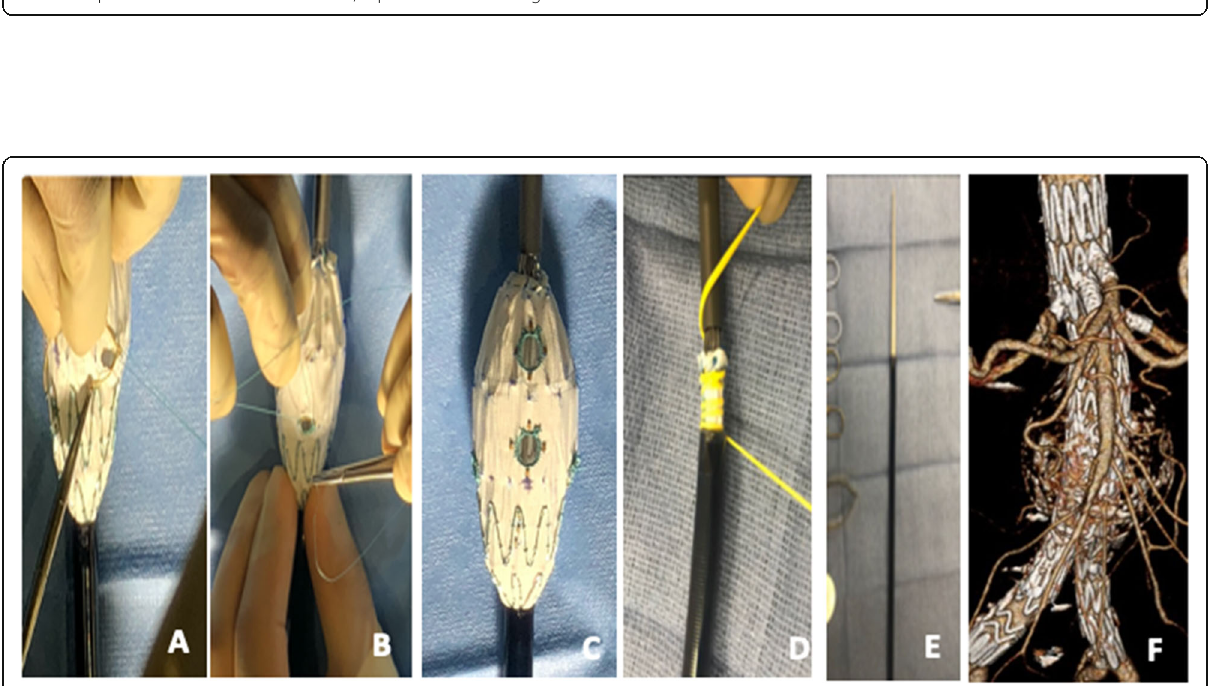
Fig. 4 A-H. Steps of modification of the Zenith Alpha thoracic stent graft. The device is deployed on a sterile back Table ( A ). The bottom stent is cut with an ophthalmologic cautery to ensure adequate length to the flow divider of the failed stent graft. Fenestrations are created and reinforced as described in Fig. 1B ( B ). The device is posteriorly constrained at every Z stent ( D ), collapsed with a silastic loop ( E ), and resheathed ( F ). Completion angiography ( G ) and 3D post-operative CTA ( H ) show exclusion of the aneurysm, perfusion of target vessels, and no endoleak. Rationale for device selection: The existing stent graft was 24 mm in diameter, the visceral aorta measured 27 mm and the distance from the bottom of the celiac artery to the flow divider was 92 mm. Furthermore, iliac arteries were small and diseased. For this reason, the low profile Alpha thoracic stent graft ZTA-PT-30-26-108-W was the perfect fit for this 3 vessel repair after removal of the distal Z stent. Resheathing of this device requires removal of laser cut barbs, a process that is